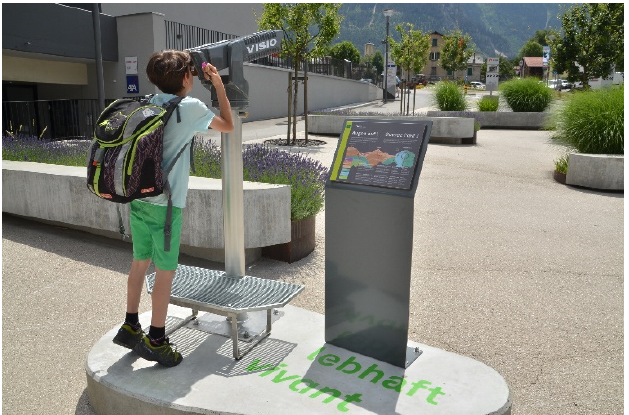
Figure 3. Illgraben Information post (Susten Switzerland) (Bureau Relief).